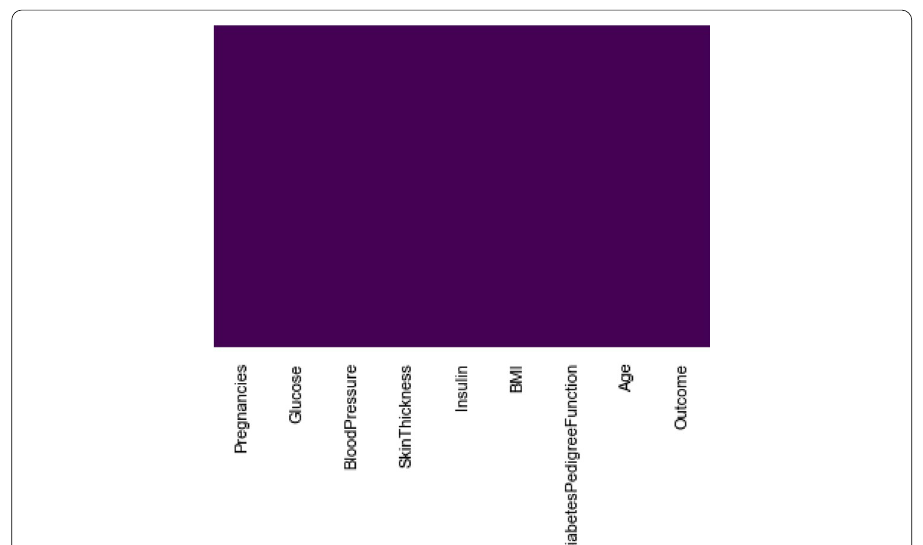
Fig. 5 After cleaning: checking missing values. In purple: non-missed value. Yellow: missed value